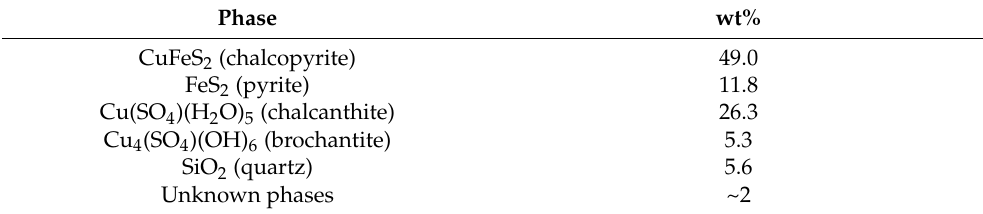
Table 2. Quantitative crystalline phase analysis by XRD of the initial chalcopyrite